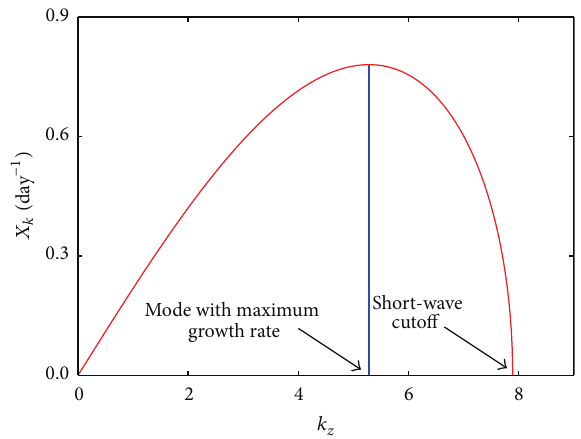
Figure 1: Growth rate 𝜒 𝑘 versus zonal wavenumber 𝑘 𝑧 for 𝜎 0 = 2 × = 40 ms −1 . 10 −6 m 2 Pa −2 s − 2 and Δ 𝜉